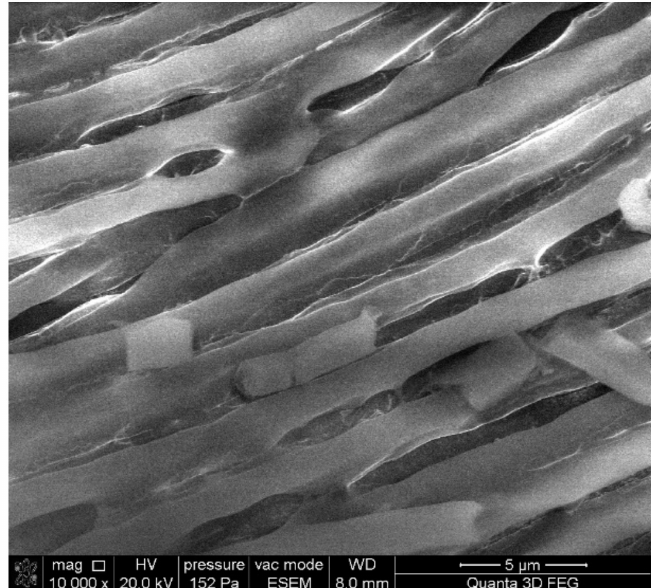
Figure 1. SEM microphotograph of the A. platensis biomass.